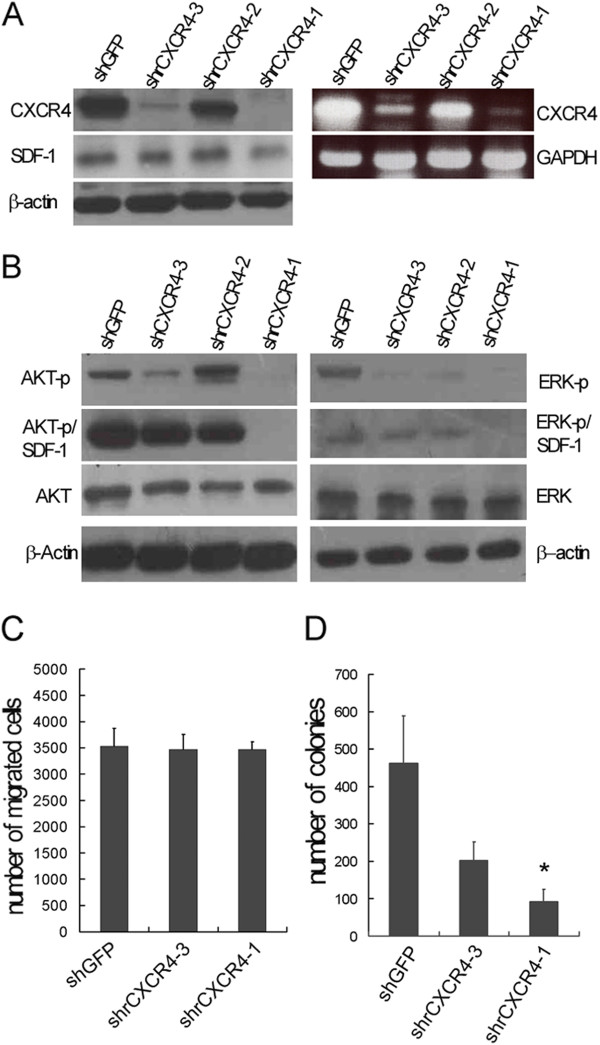
Disruption of CXCR4 abrogated signal transduction pathways and the proliferation of rat glioblastoma, RG2. (A) Representatives of combined individual clones with similar residual levels of CXCR4 from the rat glioblastoma cell line (RG2) with disrupted expression of CXCR4 by shRNA. Both western blotting and RT-PCR revealed decreased levels of CXCR4 in shrCXCR4-1 and shrCXCR4-3 clones, compared to the mock shGFP. (B) Disruption of CXCR4 impaired the phosphorylation of AKT and ERK without (AKT-p, ERK-p) or with induction of SDF1α (AKT-p/SDF-1, ERK-p/SDF-1α). (C) In vitro transwell assay indicated that inhibiting CXCR4 did not affect the invasiveness of RG2. (D) Methylcellulose colony formation assays indicated that the disruption of CXCR4 reduced the number of colonies. As shown was representative of similar results from two independent experiments.